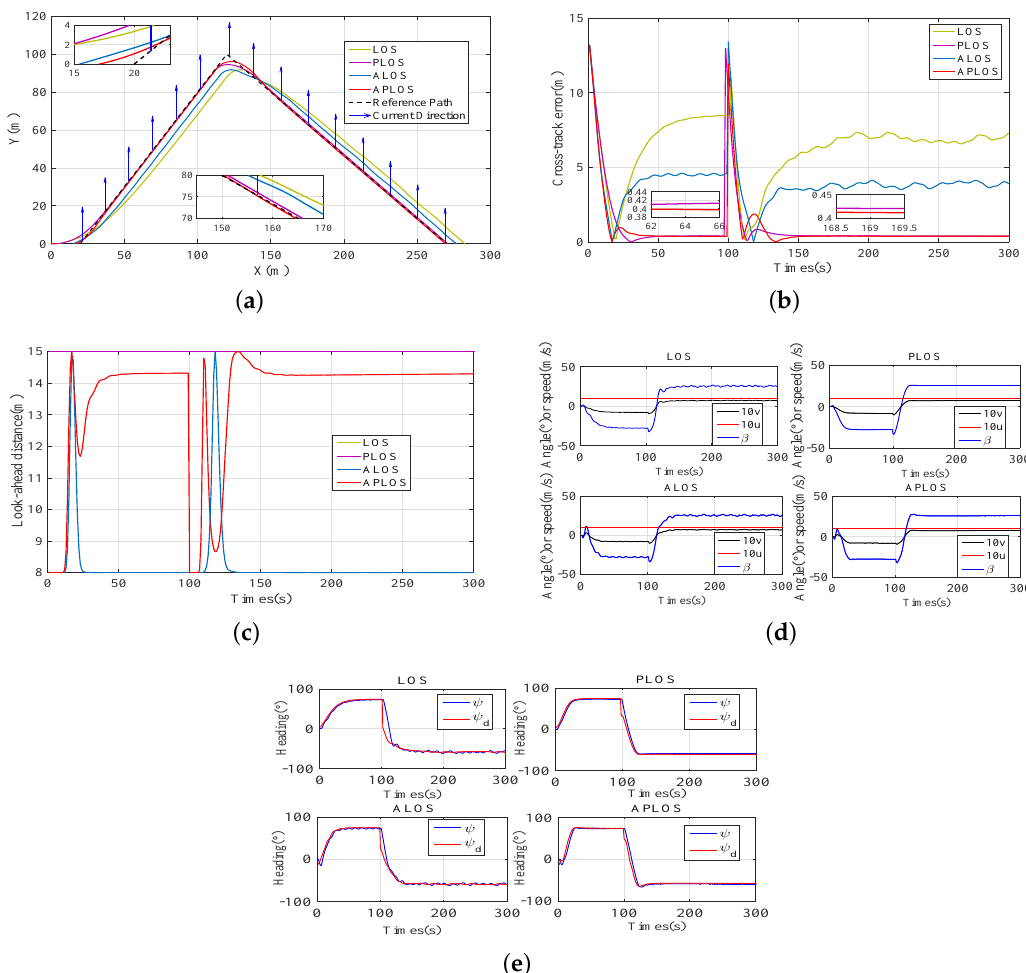
Figure 13. Zig-zag tracking under constant ocean currents ( u = 1 m/s). ( a ) comparison of trajectory; ( b ) comparison of cross-track error; ( c ) comparison of look-ahead distance; ( d ) comparison of velocity and drift angle; ( e ) comparison of heading effect.